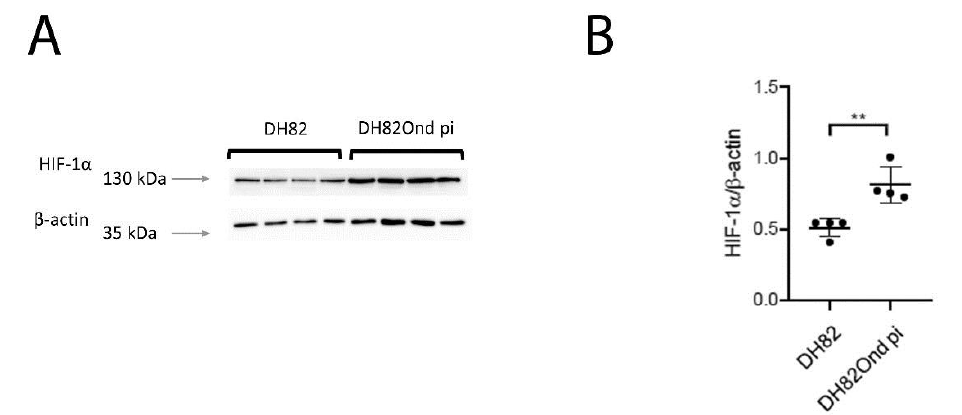
Figure 4. Immunoblotting with anti-HIF-1α and anti-β-actin antibodies revealed a single band of approximately 130 kDa and 43 kDa, respectively, when compared to the corresponding marker lengths of 130 kDa and 35 kDa (arrows, A ). ( B ) Band intensities and sizes of both HIF-1α and beta-actin were quantified and their ratio determined, revealing a significant increase of HIF-1α in persistently canine distemper virus (CDV)-infected DH82 cells compared to non-infected controls. Dot plots display means and standard deviation. Significant differences ( p ≤ 0.05, unpaired t -test.) are labeled by asterisks (** p ≤ 0.01).